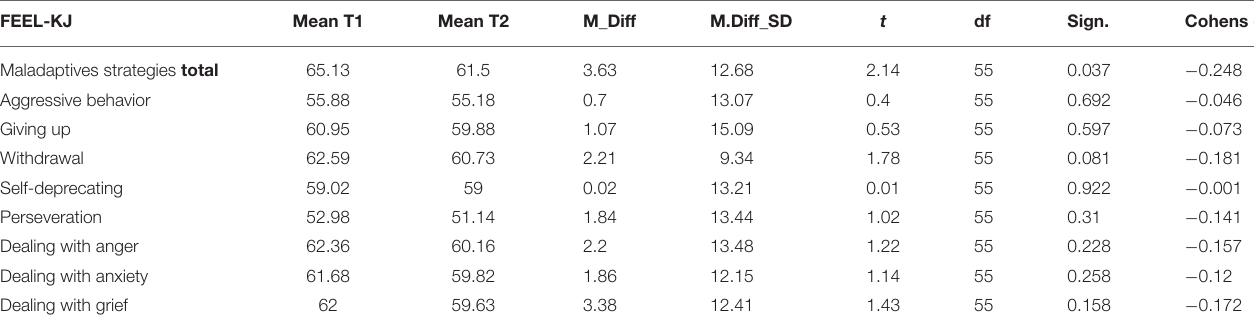
TABLE 3 | FEEL-KJ maladaptive scales.